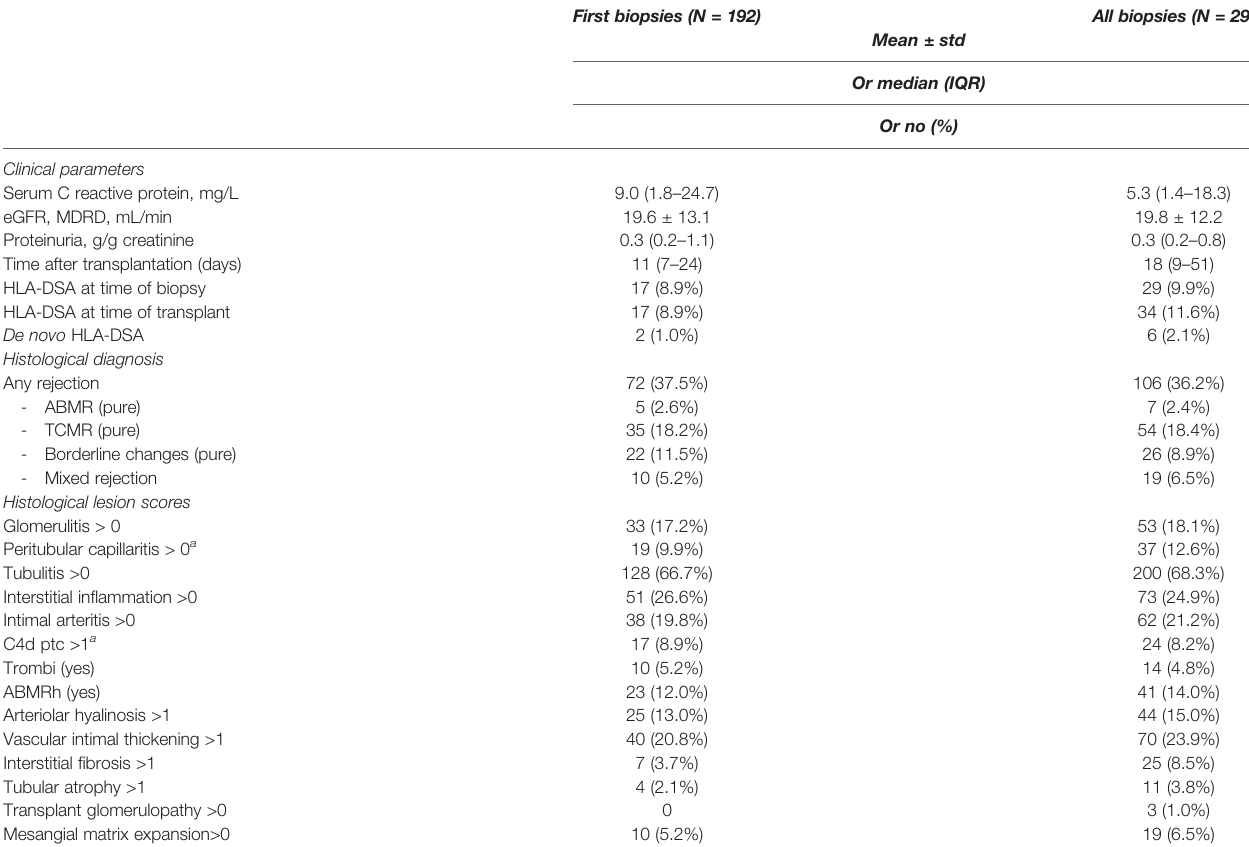
TABLE 1 | Sample characteristics of fi rst and all